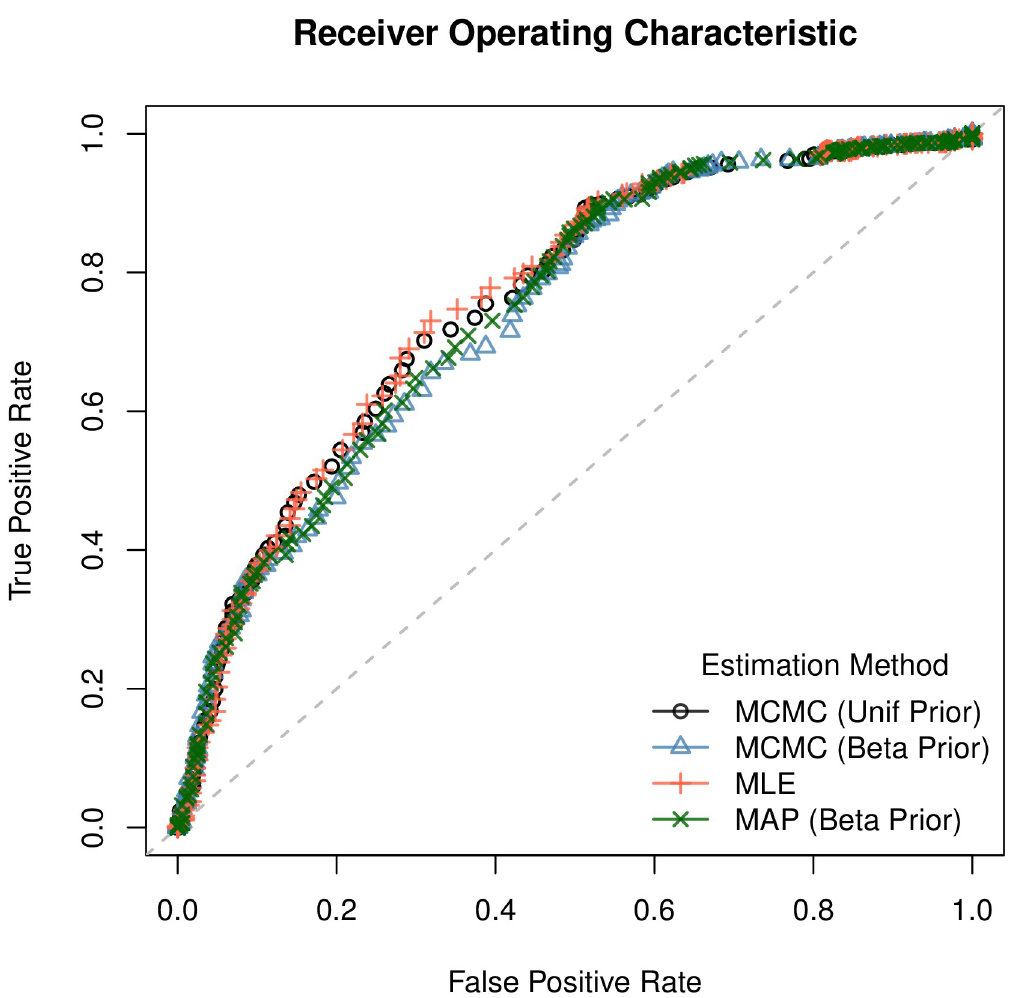
Fig 1. ROC curve for each estimation method. As reflected in the parameter estimates, ROC curves are very similar across all four